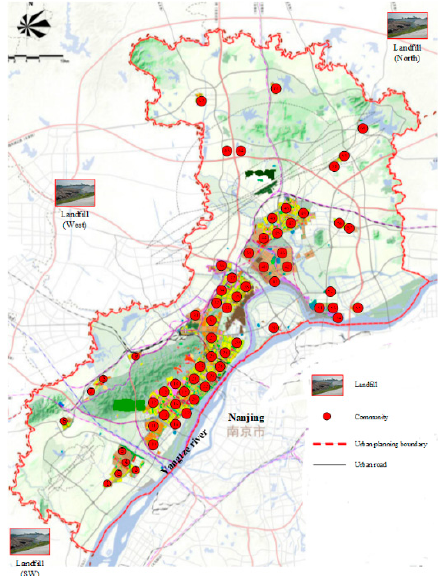
Figure 1. Population distribution and landfills in the Nanjing Jiangbei new area.